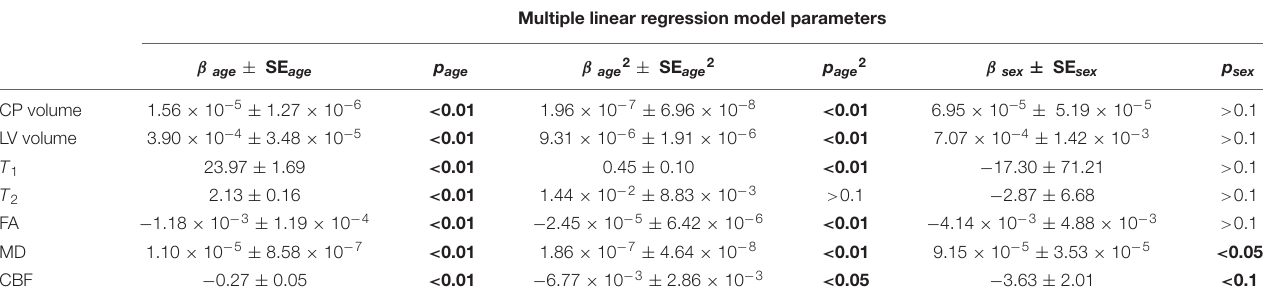
TABLE 1 | Coefficients of regression ± standard error (SE) and p -values of age, age 2 and sex incorporated in the multiple linear regression analysis for each MR measure. Multiple linear regression model